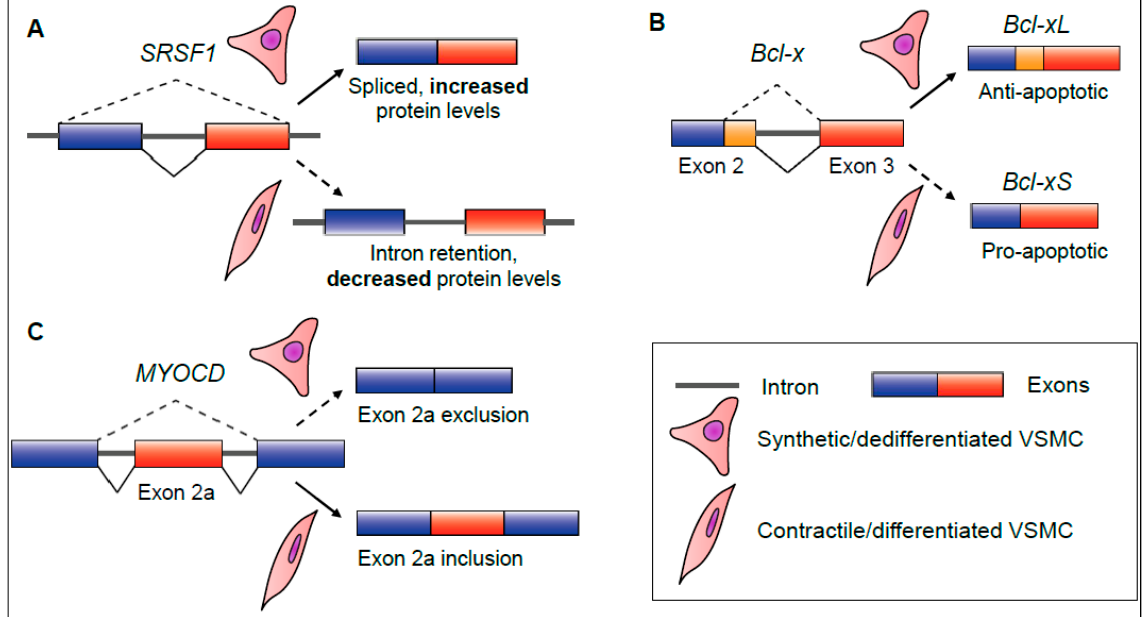
Figure 3. Examples of key splicing events which regulate vascular smooth muscle cell plasticity. ( A ) Serine/arginine-rich splicing factor 1 ( SRSF1 ) precursor mRNA undergoes increased intron retention during vascular smooth muscle cell (VSMC) differentiation. This leads to decreased SRSF1 protein expression overall. ( B ) B-cell lymphoma ( Bcl-x ) transcripts undergo alternate splice site selection to produce a long (-xL), anti-apoptotic isoform during VSMC dedifferentiation and cell growth. ( C ) Myocardin ( MYOCD ) transcripts can switch protein isoforms by excluding or including exon 2a during VSMC dedifferentiation or differentiation.